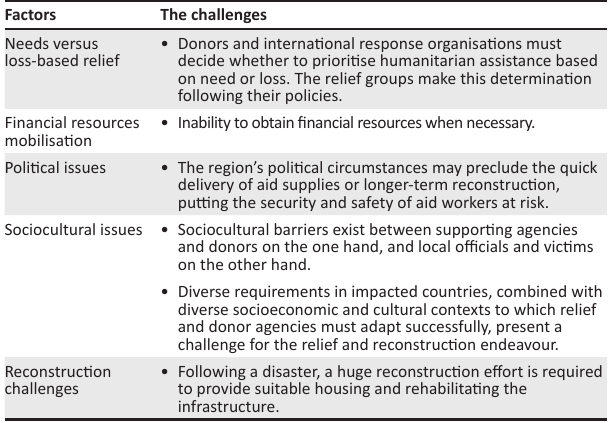
TABLE 2: Humanitarian logistics challenges. TABLE 2 (Continues…): Humanitarian logistics